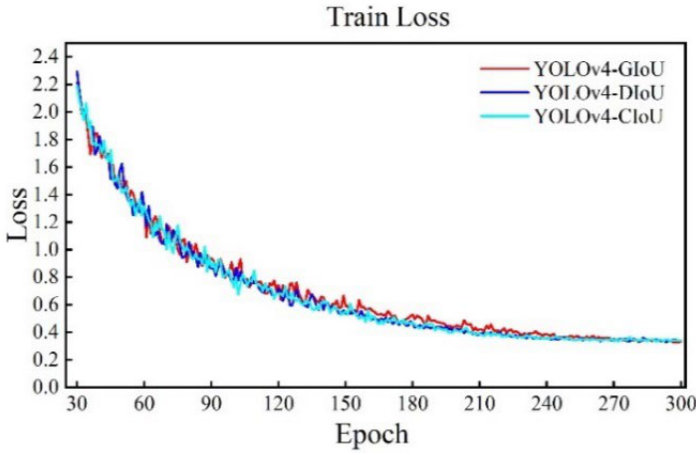
Figure 10. The loss curves for different models during training process. Table 4. The mAP and AP of each model for each defect class.